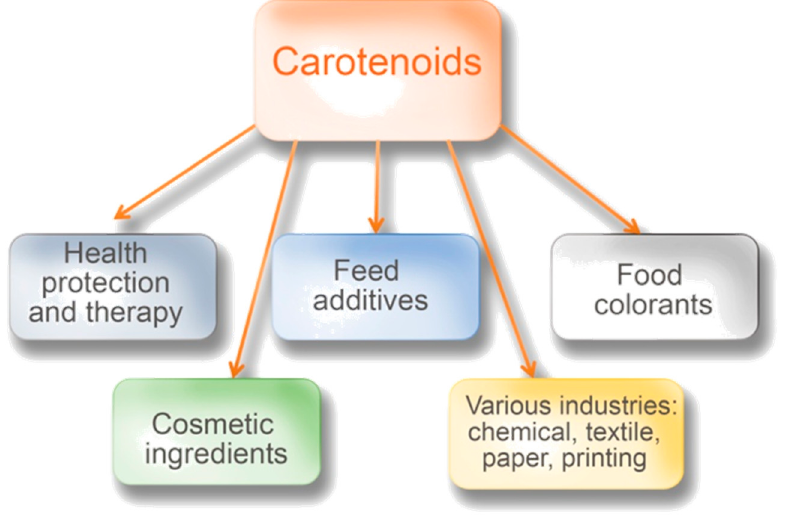
Figure 1. Current and potential use of carotenoids.